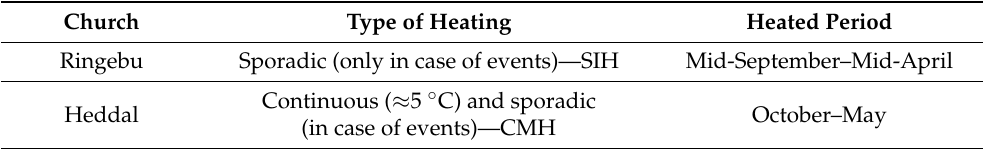
Table 2. Use of heating in Ringebu and Heddal stave